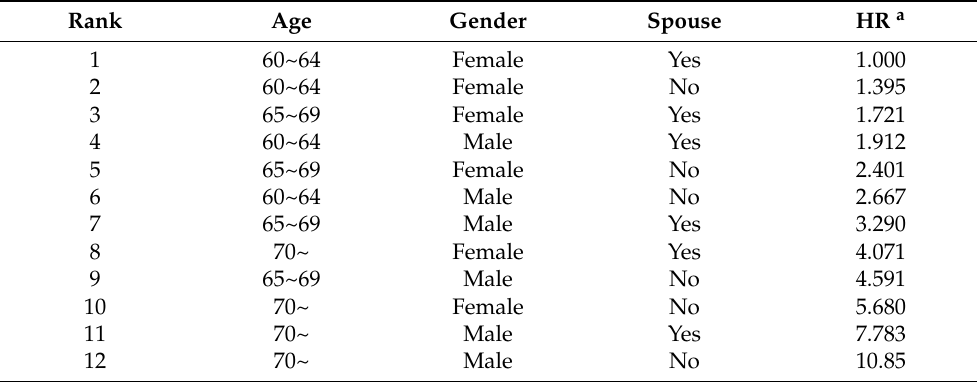
Table 4. The hazard ratios by age, gender, and spouse.